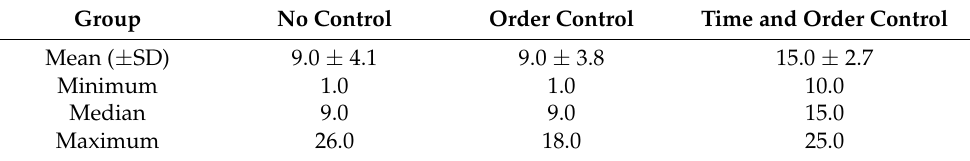
Table 5. Number of days 1 taken for the home use test (HUT) with six samples.